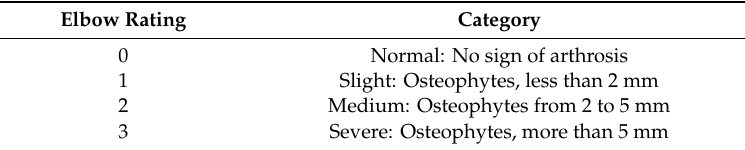
Table 2. Elbow rating